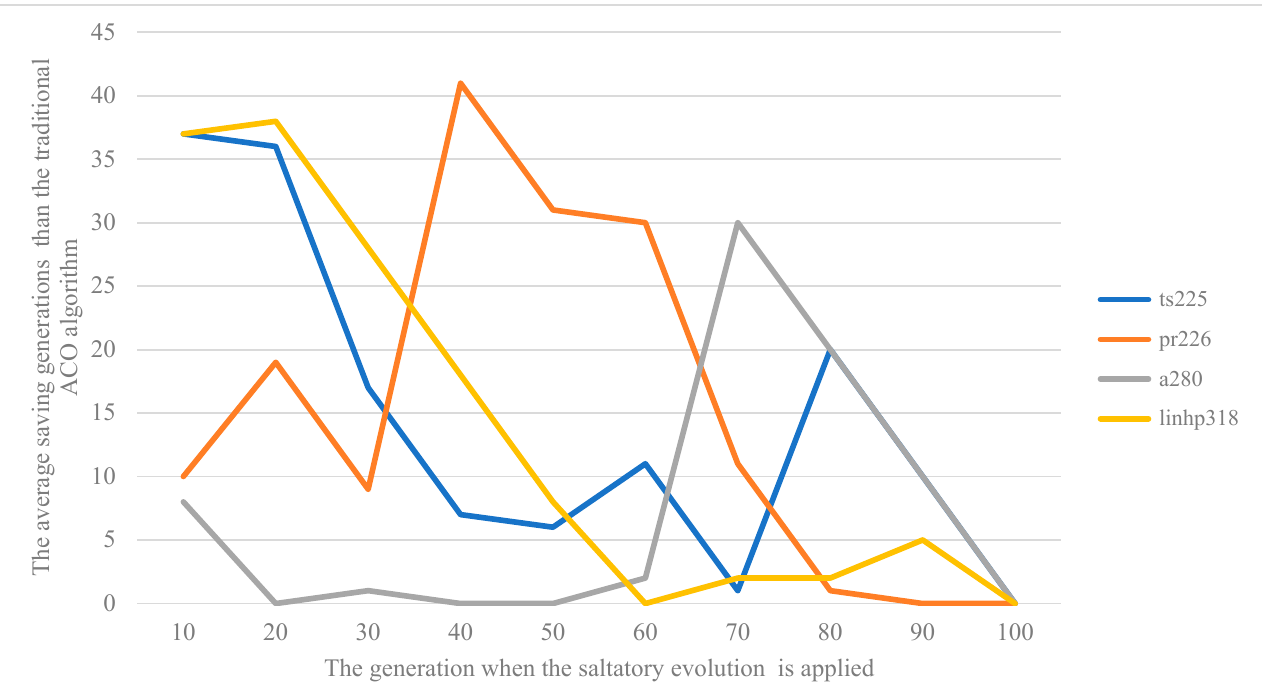
Figure 7. The optimization results of SEACO algorithm for data sets where n is in (200, 400).